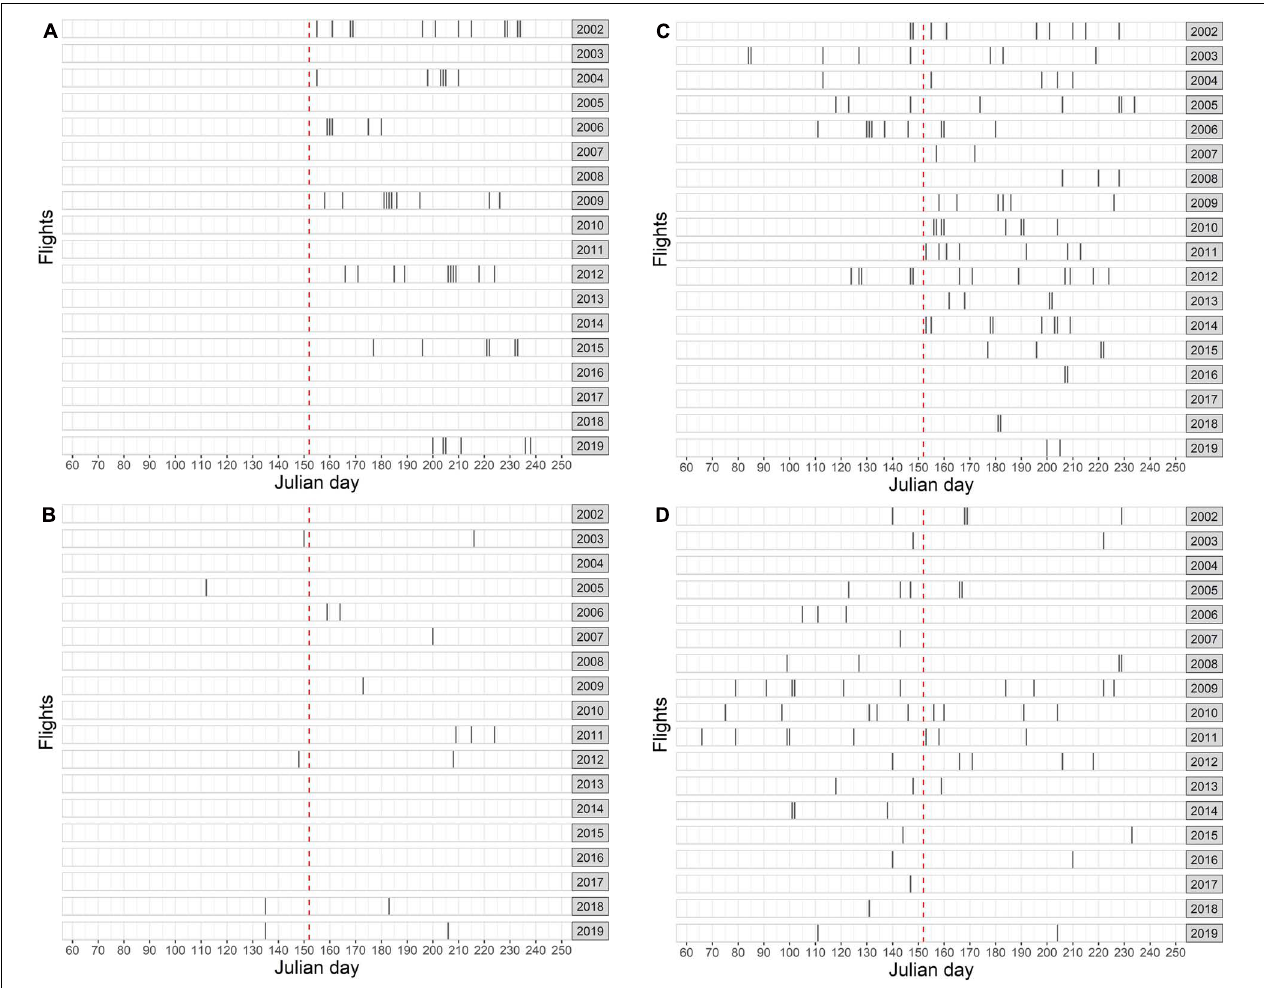
FIGURE 4 | Aerial survey flights in the different study areas: (A) German North Sea EEZ, (B) SAC Dogger Bank, (C) SAC Sylt Outer Reef, (D) SAC Borkum Reef Ground. Timing of each flight is shown with respect to the Julian day. The red dashed line shows the transition from spring to summer.